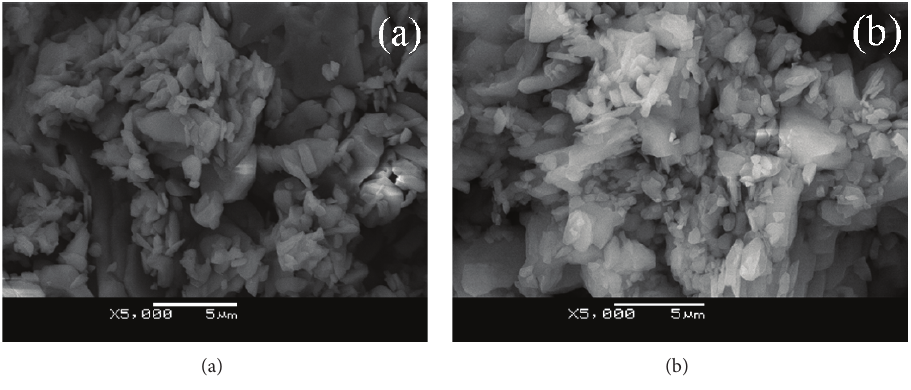
Figure 5: SEM images of as-prepared SLCB (a) and ELCB